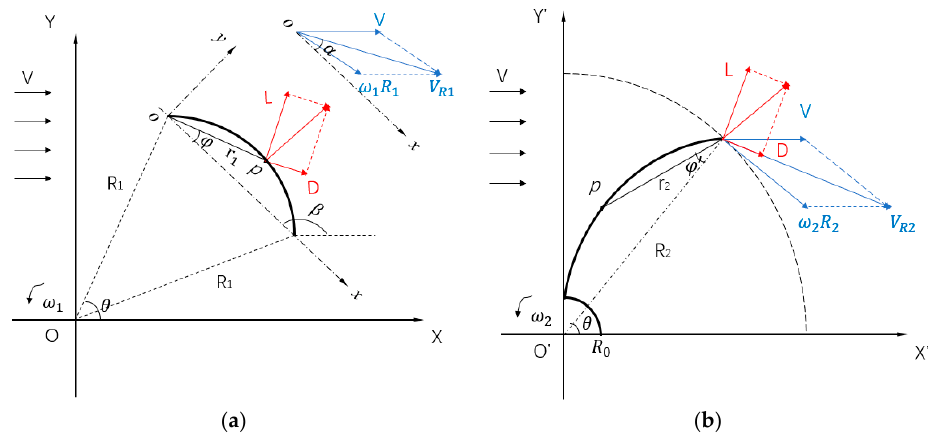
Figure 4. Schematic diagrams of the blade section motion and the force analysis: ( a ) is driven by axial flow and ( b ) is driven by radial flow.